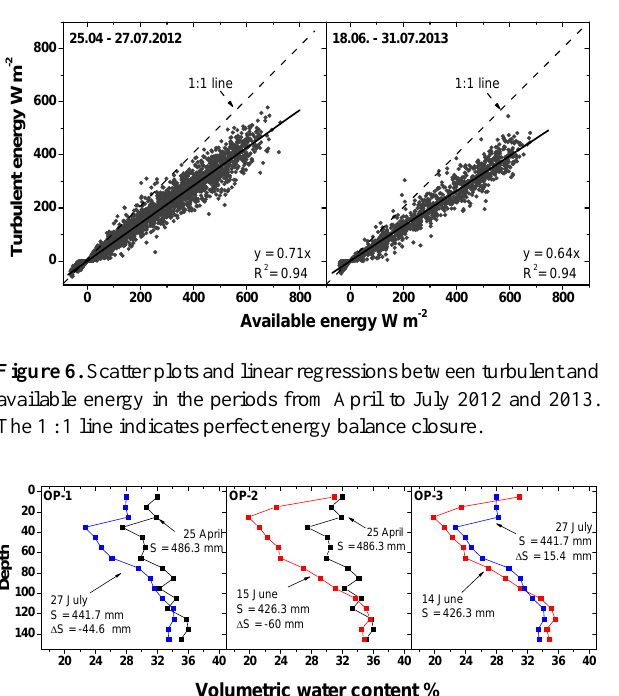
Figure 7. Vertical soil water profiles and change in water storage over three observation periods (OPs) at winter wheat stands at EC3 in